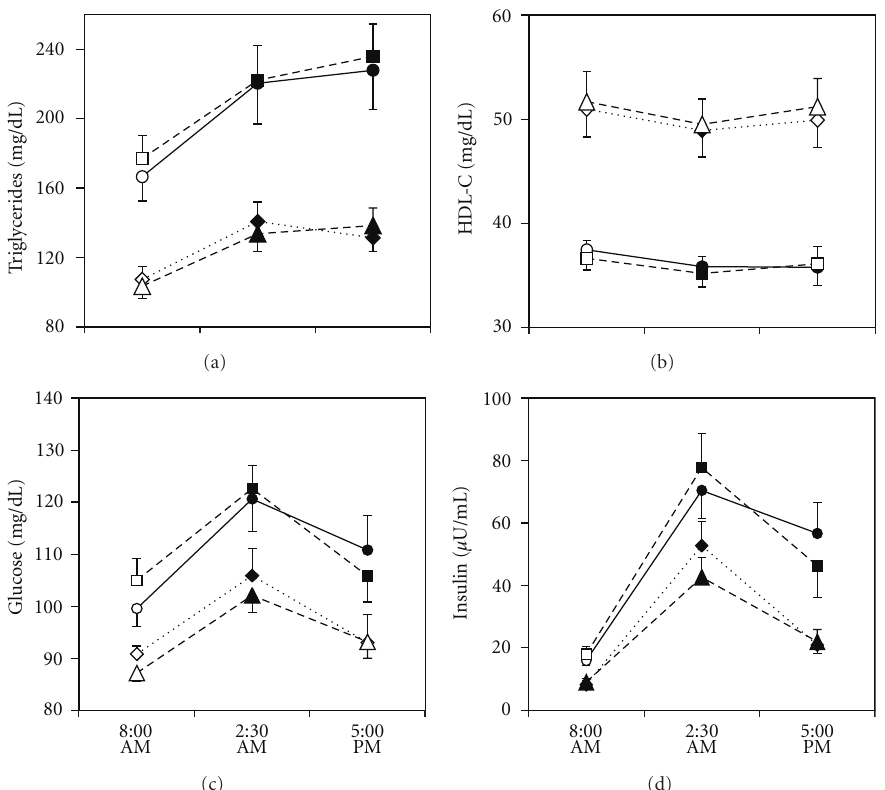
Figure 2: Line plots show the postprandial responses of serum triglycerides, HDL cholesterol, blood glucose, and insulin in patients on low-fat and on low-carbohydrate diet. ( – (cid:2) – ) MetS+ low-CHO meal; (-- (cid:3) --) MetS+ low-fat meal; (-- (cid:4) --) MetS − low-CHO meal; (-- (cid:2) --) MetS − low-fat diet. Vertical bars are the standard error of the mean. Filled symbols represent significant di ff erence from baseline.